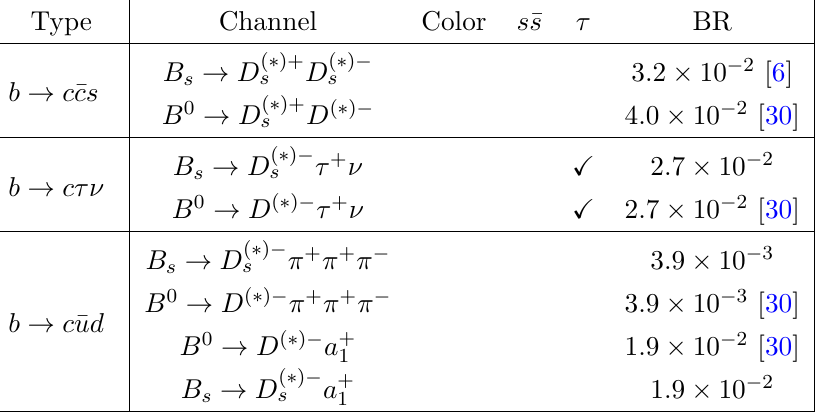
Table 8 . Major backgrounds for the B s → τ + τ − measurement. “Color”, “ s ¯ s ” and “ τ ” represent the three effects suppressing the B -meson decays which are discussed in the text. The π ± π ± π ∓ appearing in the first two b → c ¯ ud channels are produced